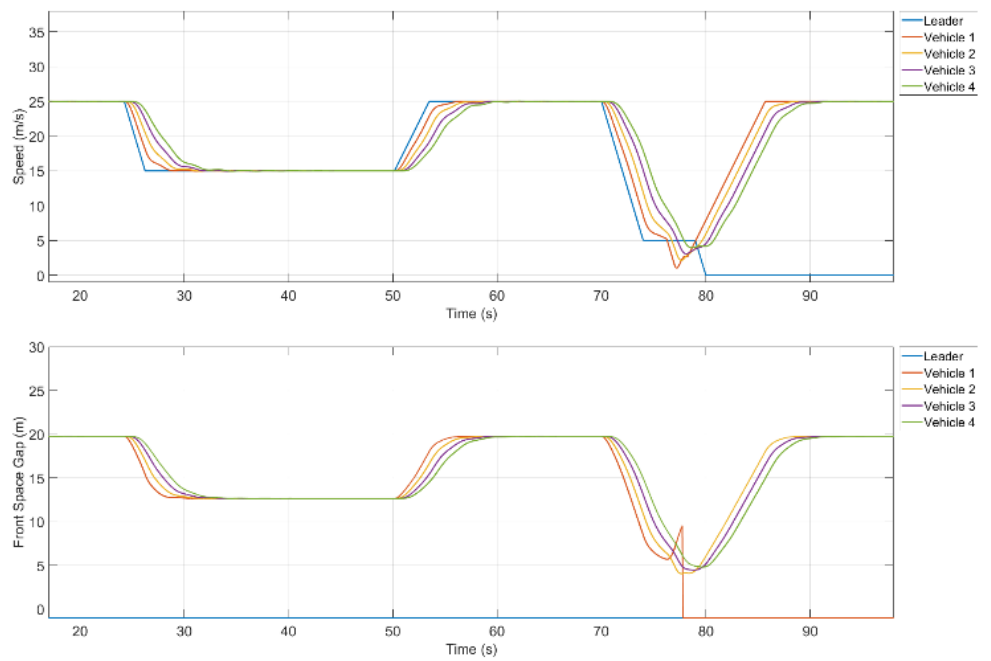
Figure 16. Simulation results for speed ( upper ) and inter-vehicle distance ( lower ) for resilient scenario.